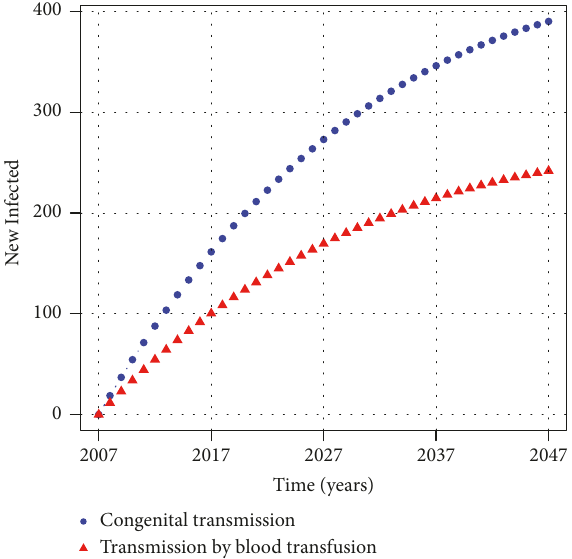
Figure 3: Comparison of the number of cumulative new infections along time when a single transmission route is considered.